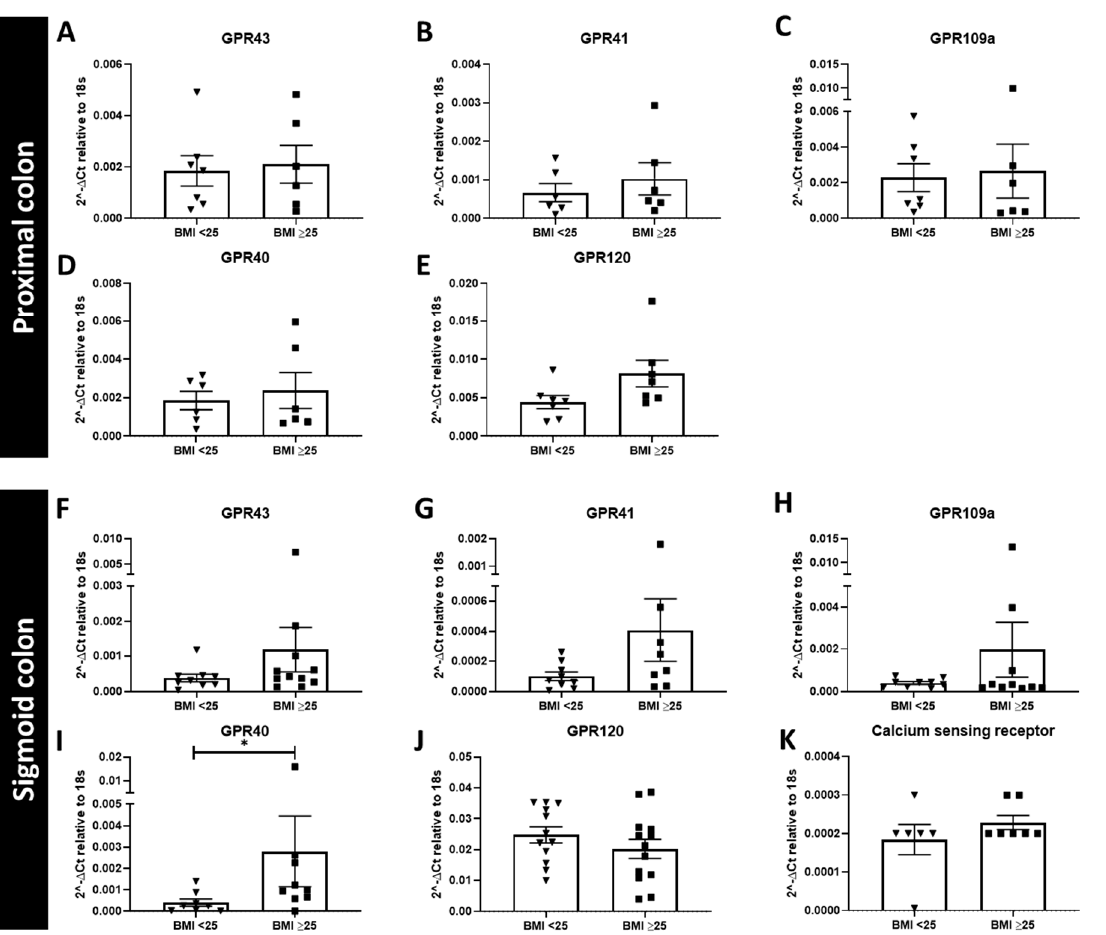
Figure 3. Relative mRNA expression of genes for nutrient receptors in the proximal and sigmoid colonic tissue from a Dutch cohort. Relative expression (against 18s) of nutrient receptors in the proximal ( A – E , n = 6–7) and sigmoid colon ( F – K , n = 6–13) with patients divided into those with a BMI < 25 and BMI ≥ 25, respectively, * significant increase.